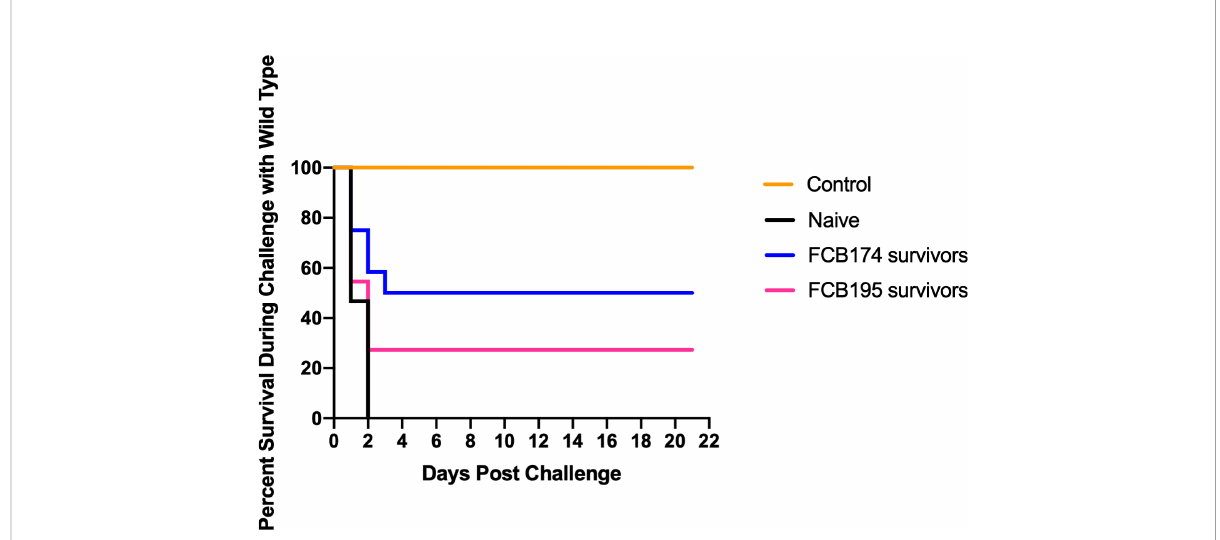
FIGURE 11 Challenge of rainbow trout fry survivors with wild type F. columnare . Fish that survived exposure to mutants predicted to be de fi cient in multiple steps of iron uptake were examined for later resistance to challenge with wild-type cells. Naïve fi sh, FCB 174 survivors, and FCB195 survivors were maintained for 28 days and then exposed to F. columnare wild type (7.1 x 10 6 CFU/ml). Naïve fi sh were not previously exposed to F. columnare . Control indicates fi sh exposed to equivalent amount of TYES growth medium instead of to F. columnare. Signi fi cant differences in the percent survival were seen for the naïve fi sh and FCB174 survivors (P <